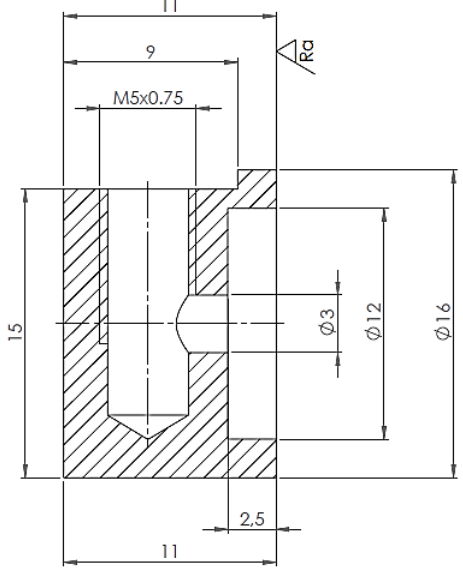
Figure 2. A cross-sectional view of the part subjected to leakage tests.